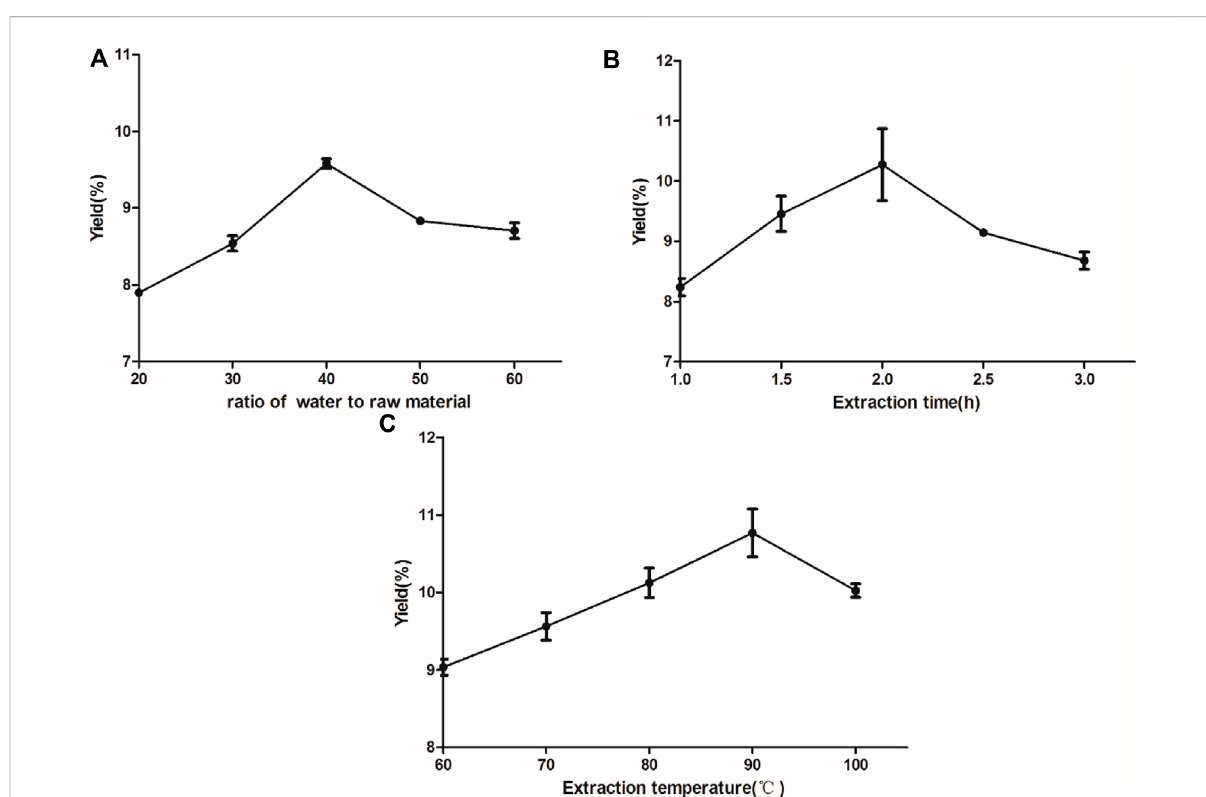
FIGURE 1 Effect of different feed-to-liquid ratio (A) , extraction time (B) and extraction temperature (C) on theextractionrate ofRFP. (A) Experimentswith different ratios of water to raw material (20:1, 30:1, 40:1, 50:1, 60:1) (B) Experiments with different extraction times (1, 1.5, 2, 2.5, 3 h) (C) Experiments with different extraction temperatures (60, 70, 80, 90, 100 °